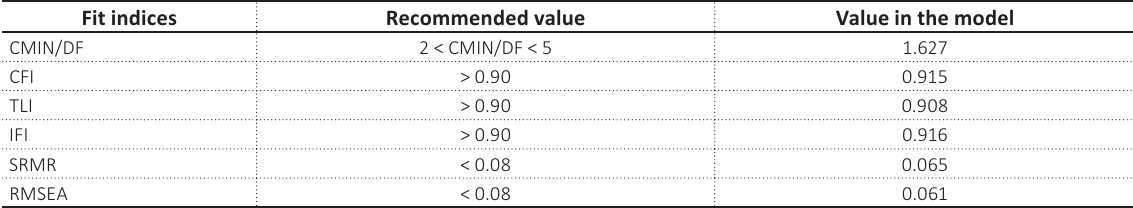
Table 3. Goodness-of-fit indicators in the measurement model